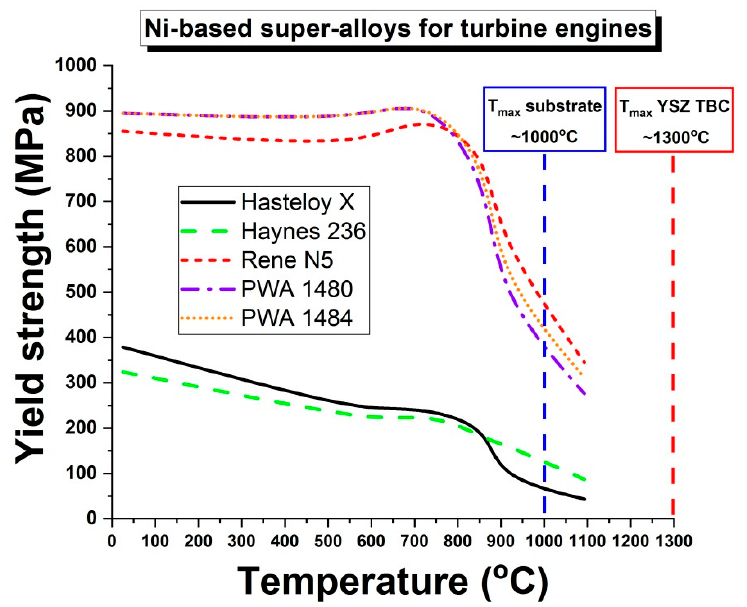
Figure 1. Yield strength versus temperature for different Ni-based superalloys employed in the hot-sections of gas turbine engines—adapted from [17].